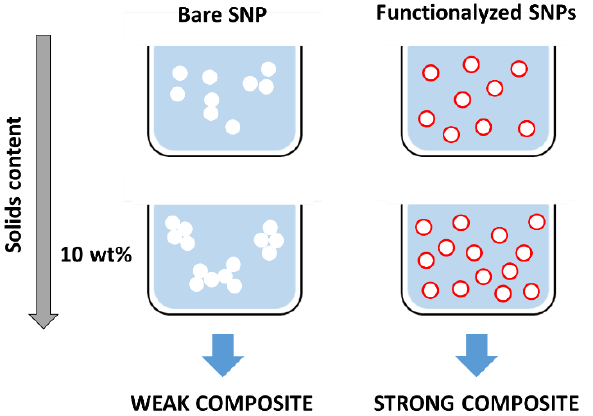
Figure 3. Optimization of hybrid coatings often involve the incorporation of up to ca. 10 wt% of SPNs in polymer material. At such solids content bare SNPs tend to aggregate, resulting in a weak composite ( left ). By appropriately functionalizing the SNPs ( right ), it is possible to obtain homogeneous distributions of the SNPs in the dispersion and polymer matrix, leading to better composite performance.